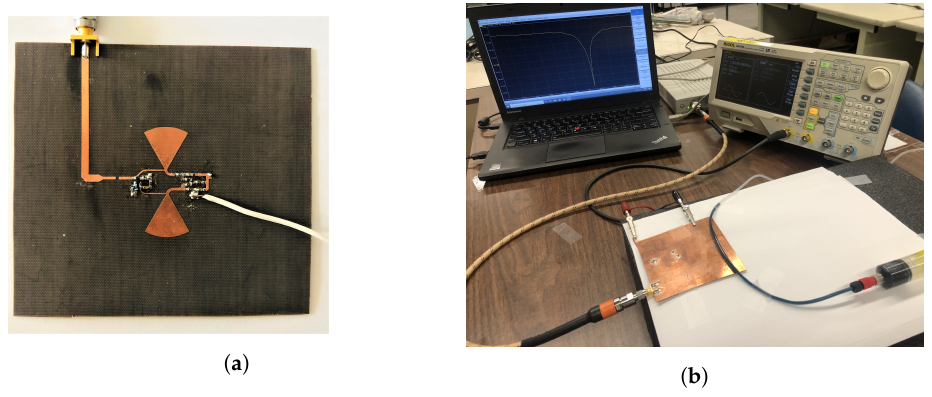
Figure 10. ( a ) Fabricated sensor, top view; ( b ) test